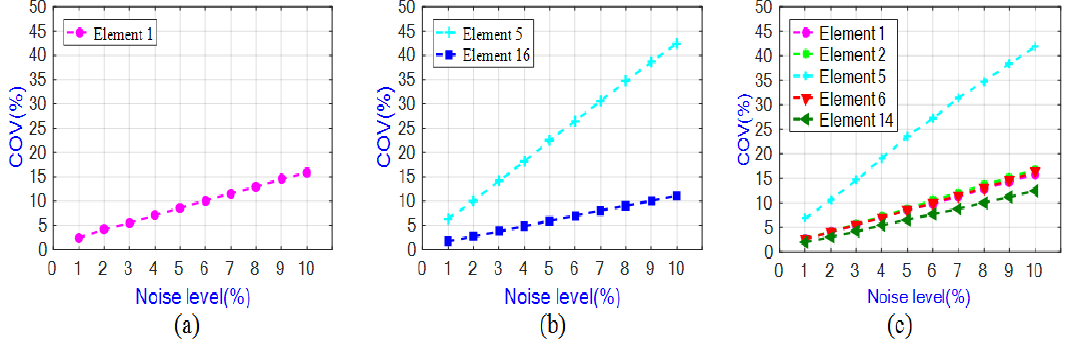
Fig. 4. Coe(cid:30)cients of variances for damaged elements in the case of di(cid:27)erent noise levels: (a) Scenario A; (b) Scenario B; (c) Scenario